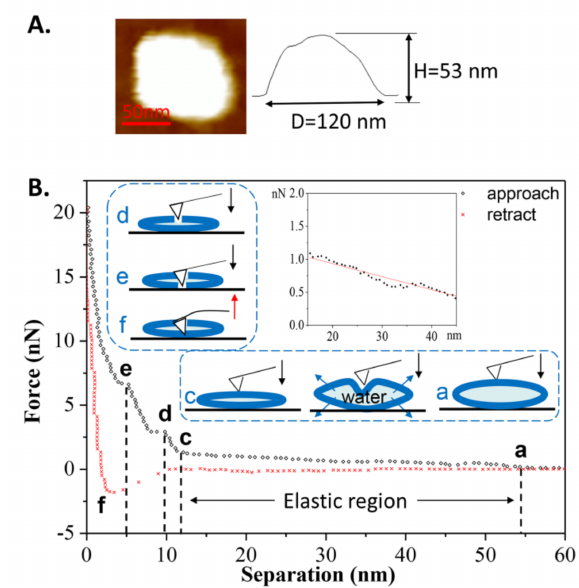
Figure 5. ( A ) AFM image of the vesicle prior to the first approach; ( B ) The force-distance curve and the schematic procedures describing the first tip approach and retraction on the DPPC vesicle were obtained at T 2 = 25 ◦ C. The inset shows the linear relationship between the normal force and separation (elastic